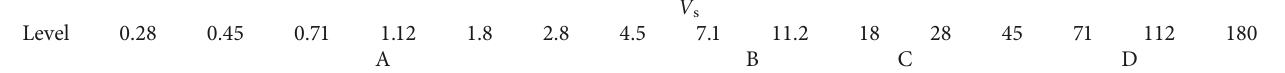
Table 2: More than 2-cylinder diesel engine vibration quality grading evaluation table.